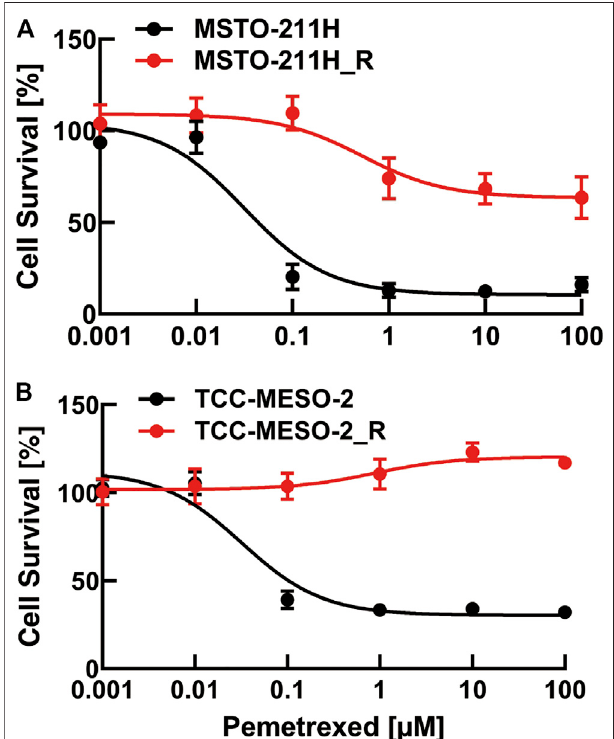
FIGURE 1 | Viability of pemetrexed (PMX)-treated parental and PMX- resistant cells. (A) MSTO-211H and MSTO-211H_R and (B) TCC-MESO-2 and TCC-MESO-2_R cells were treated with the indicated concentration of PMX for 72 h, and their viability was assessed by WST-8 assay. The percentage(%)viabilitydataareshown asthemean ± standarddeviation(SD) ( n (cid:2) 6). Error bars indicate the range of